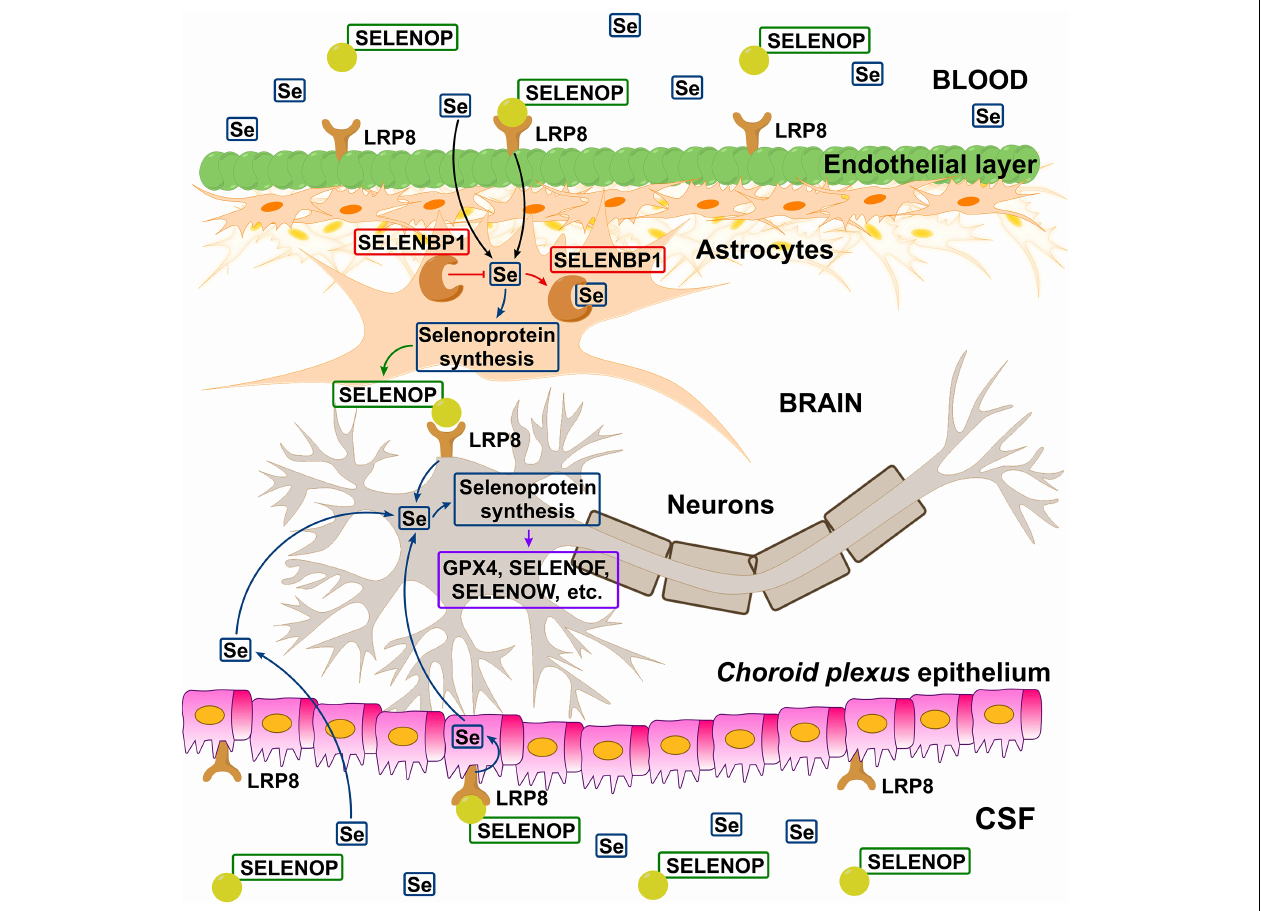
FIGURE 2 | Hypothetical model of Se transport across blood–brain barrier (BBB) and blood–cerebrospinal fluid barrier (BCB). Circulating SELENOP present in blood and CSF is taken up by LRP8-positive cells in the epithelial (BBB) and ependymal (BCB) layers, resynthesized in neighboring astrocytes, and released to supply LRP8-positive neurons with Se. In the astrocytes, SELENBP1 sequesters Se from selenoprotein synthesis and thus negatively regulating SELENOP production. There is also evidence indicating the existence of the SELENOP-independent Se uptake pathway ( Figure 1 ). Reproduced from Sasuclark et al. (2019) with